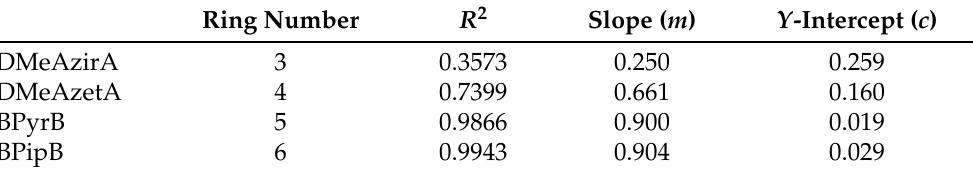
Table 6. Linear regression analysis of DMeAzirA; three-member ring, DMeAzetA; four-member ring, PByrB; five-member ring and BPipB; six-member